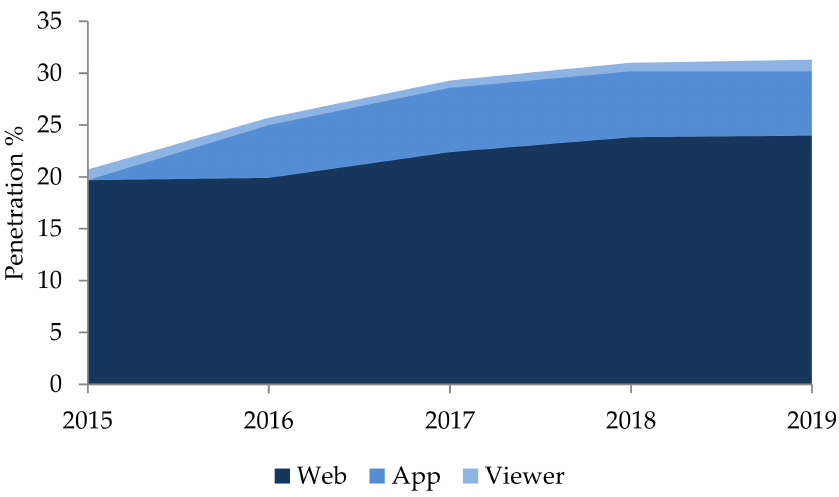
Figure 7. Evolution of newspaper audiences by format device (Penetration %). Compiled by the authors on the basis AIMC (2020) [41] data.